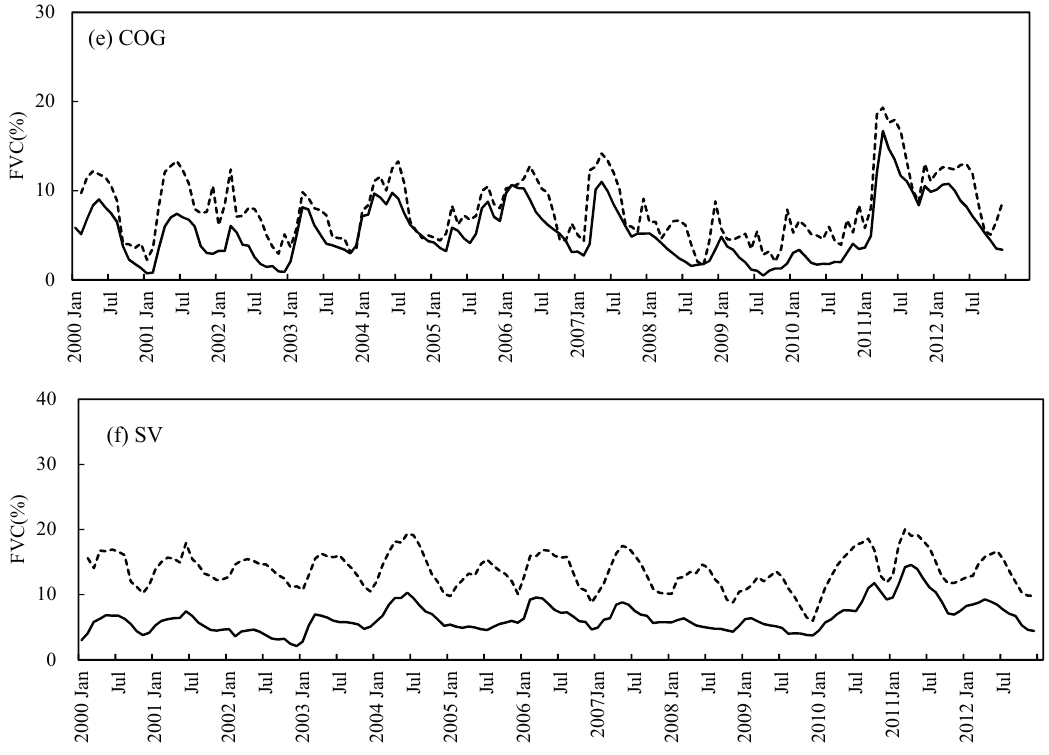
Figure 4. Interannual and seasonal variations of the GEOV1 and Australian MODIS FVC products over the main biome types of Australia during the 2000–2012 period. ( a ) rainfed croplands (RC), ( b ) closed to open broadleaved evergreen forest (COBEF), ( c ) open broadleaved deciduous forest (OBDF), ( d ) closed to open shrubland (COS), ( e ) closed to open grassland (COG), and ( f ) sparse vegetation